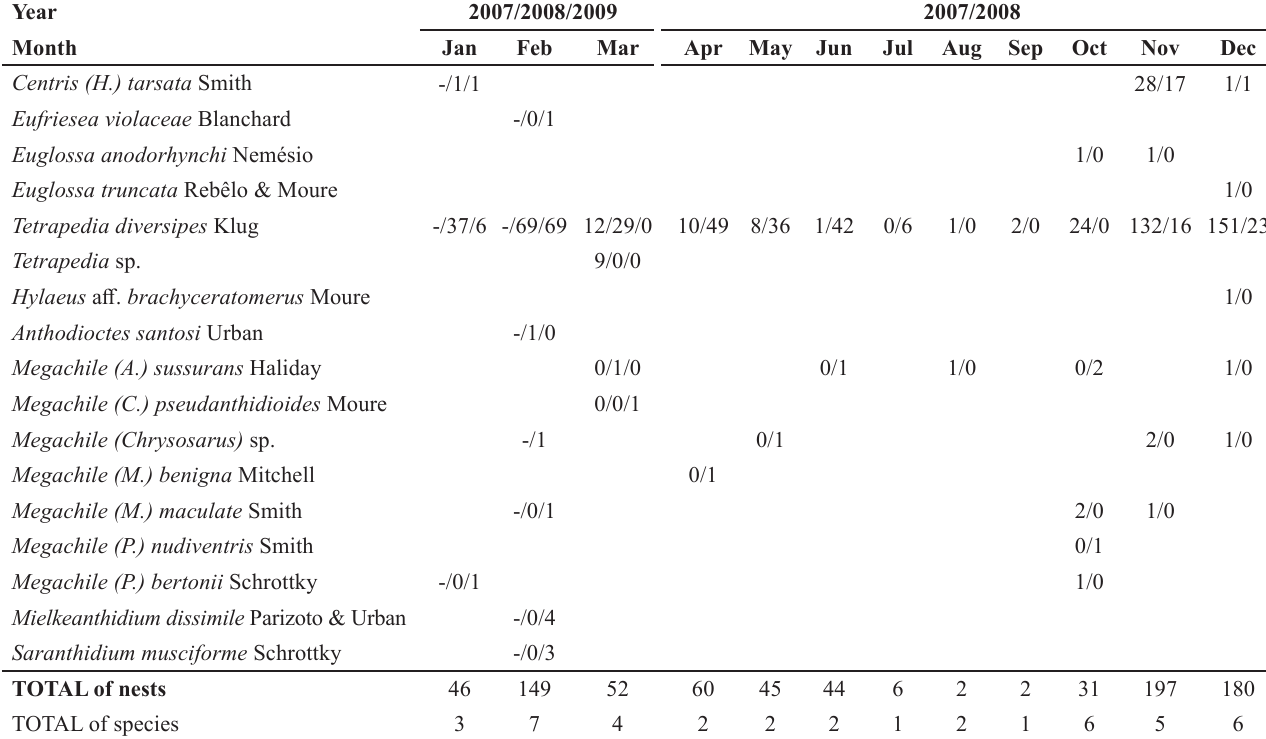
Table 2 . Number of nests founded by bees each month sampled from March 2007 to February 2009. (-) Before starting the study.